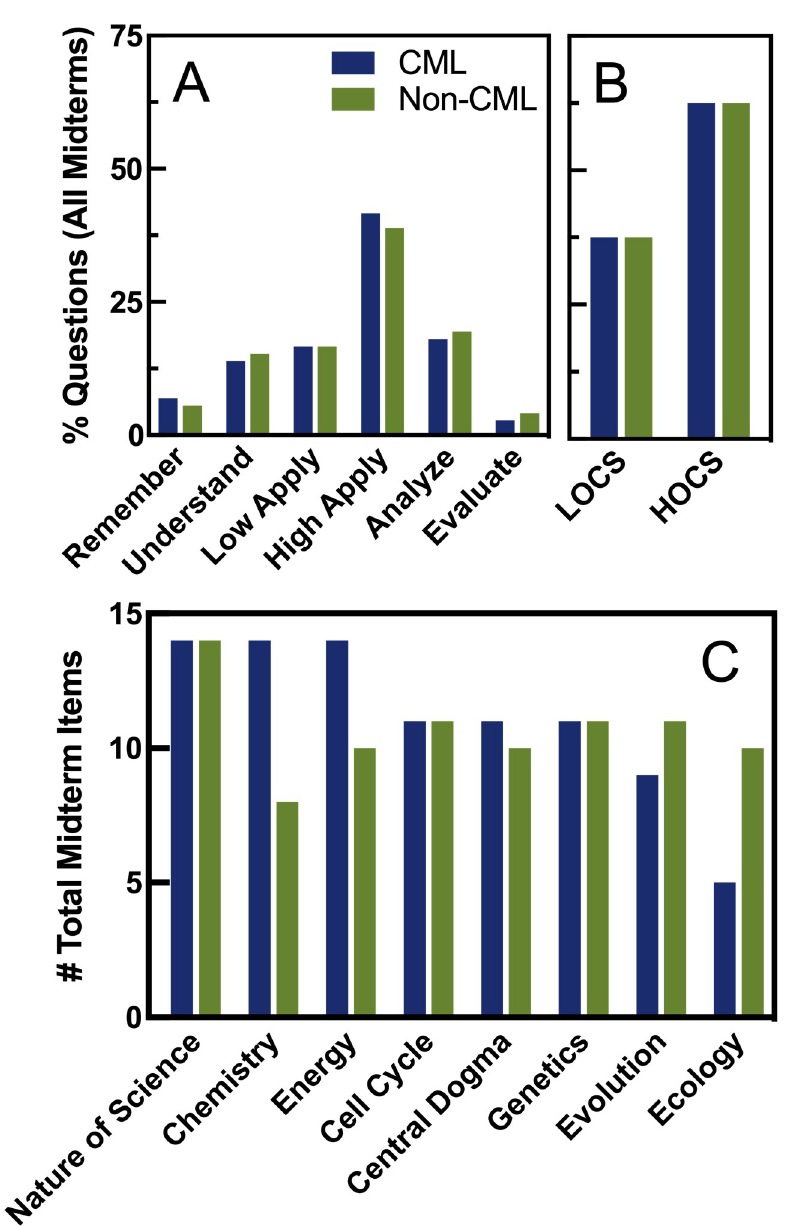
Fig 2. Midterms were equivalent in terms of cognitive skill, but topics could not be covered equally. Panel A: All cumulative (blue) and non-cumulative (green) midterm exam items were categorized by Bloom’s taxonomy, and percent of total is shown on the y axis. Counts were indistinguishable by section ( X 2 (5, n = 144) = 0.46, p = 0.99). Panel B: All midterm exam items categorized by LOCS and HOCS are shown as a percentage of the whole on the y axis. Counts were indistinguishable by section ( X 2 (1, n = 144) < 0.001, p > 0.99). Panel C: Total number of midterm items covering each course topic is shown for each section. Course topics are shown in the order in which they were covered in the